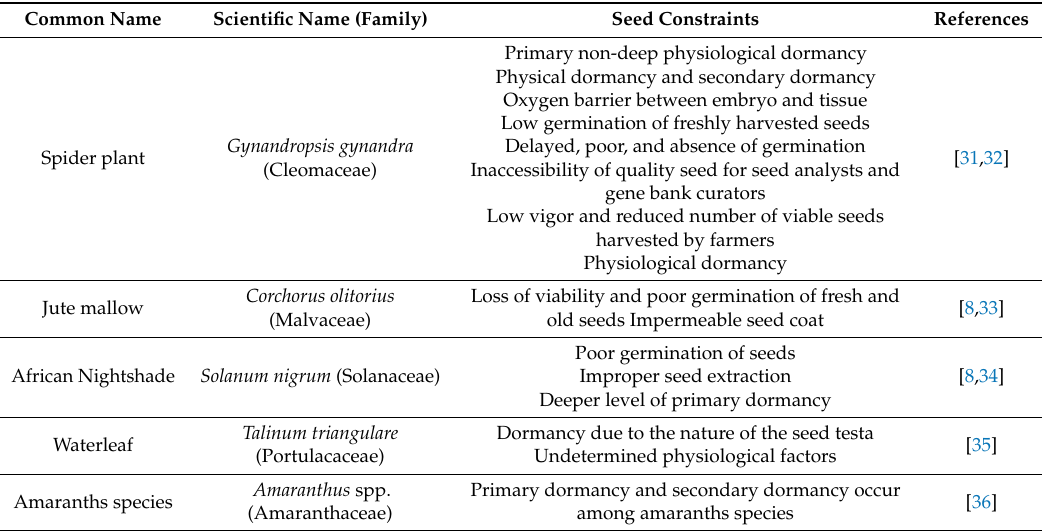
Table 1. Seed constraints and dormancy types reported for traditional leafy